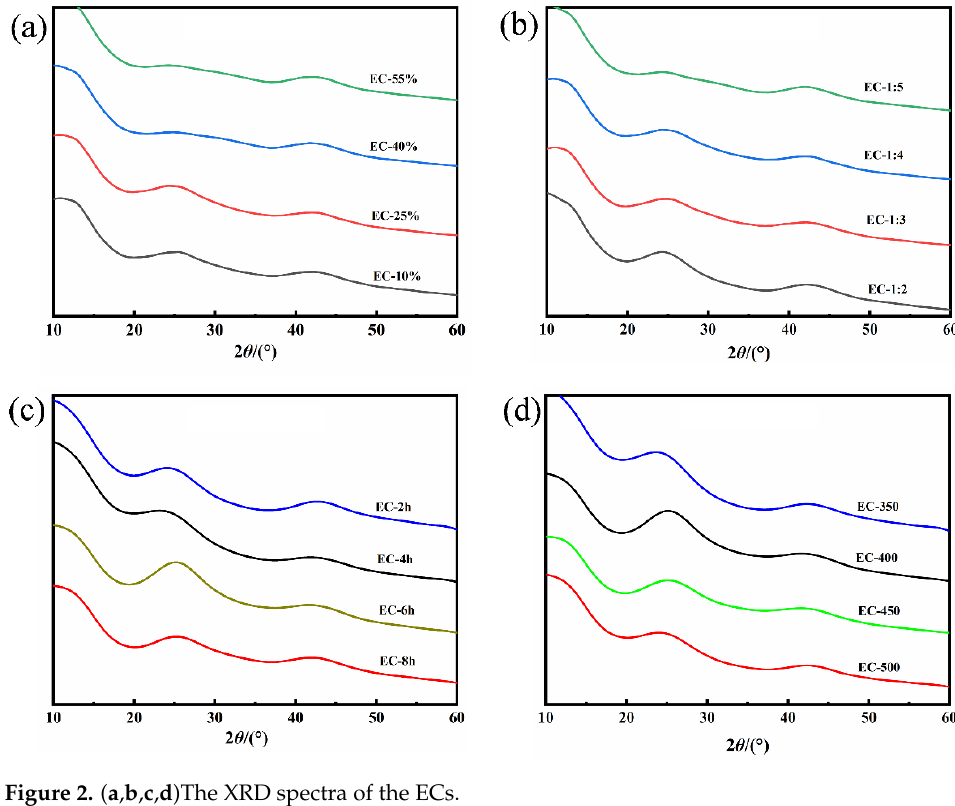
Figure 2. ( a , b , c , d )The XRD spectra of the ECs.